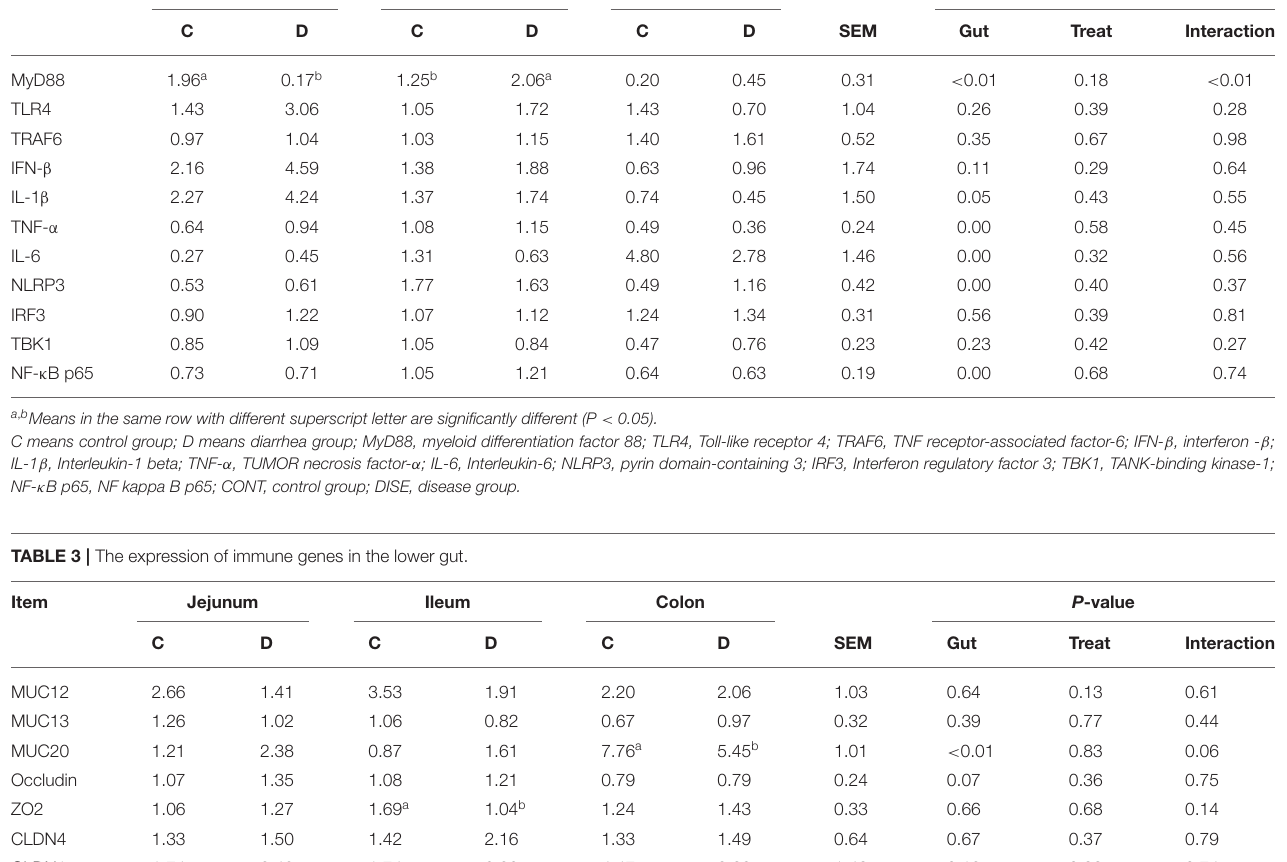
SEM Gut Treat Interaction